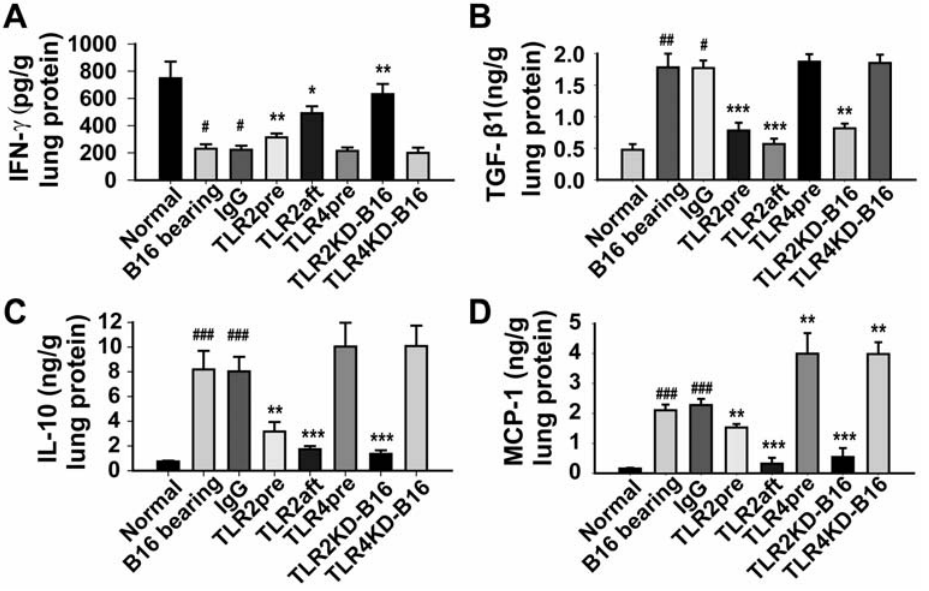
Figure 4. Targeting TLR2 altered the production of cytokines in the lungs. Animals were treated as indicated in the Figure 3 legend. Supernatants were obtained from a homogenate of lung tissue to detect the levels of cytokines, including IFN- c (A), TGF- b 1 (B), IL-10 (C), and MCP-1 (D). Data are represented as mean 6 SE of three independent experiments (n=8/group/experiment). * P , 0.05, ** P , 0.01, *** P , 0.001 versus B16 cell bearing mice; # P , 0.05, ## P , 0.01, ### P , 0.001 versus sham